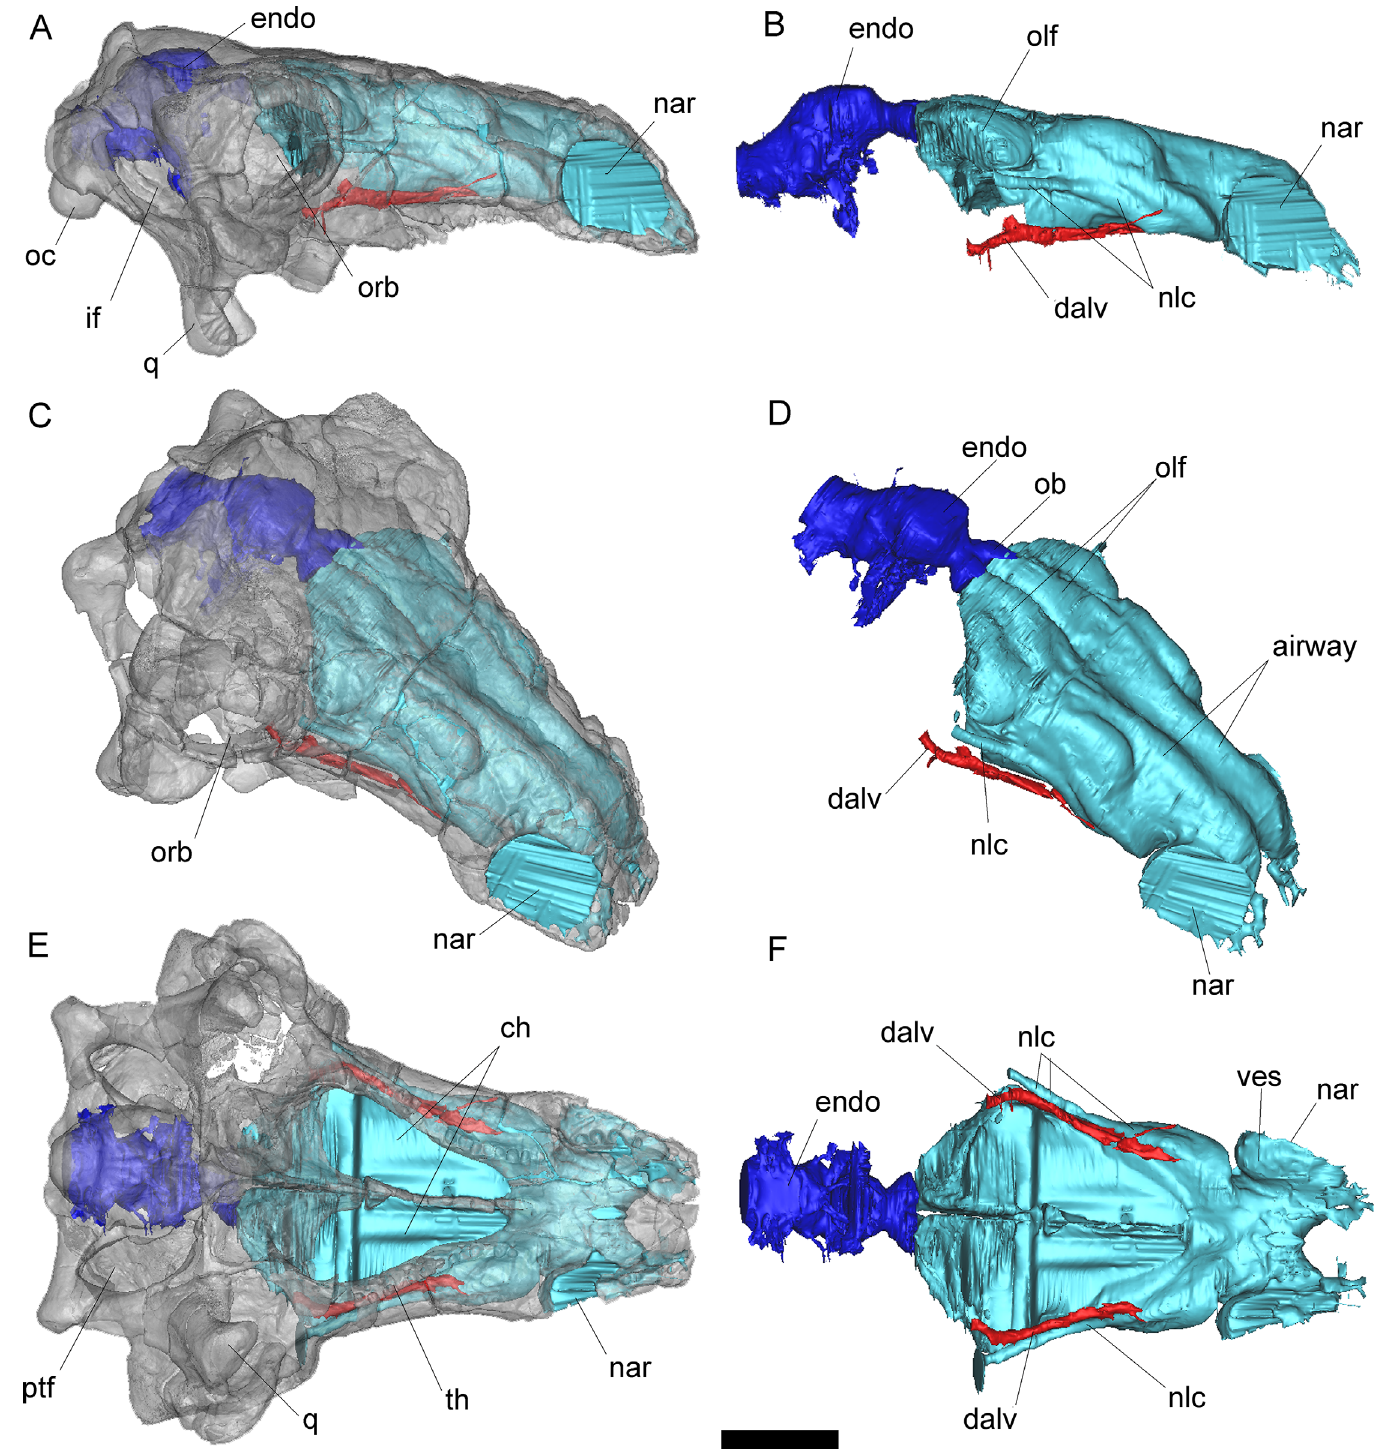
Fig 2. Volume-rendered CT-based reconstruction of the skull of the nodosaur dinosaur Pawpawsaurus campbelli (FWMSH93B.00026). In the images of the left side the bone is rendered semitransparent to show the endocranial cavity (in blue) and the nasal cavities (in light blue). Skull right lateral (A, B), right anterolateral (C,D) and ventral (E,F) views. Abbreviations: ch, choana; endo, cranial endocast; if, lateral temporal fenestra; nar, external nostrils; oc, occipital condyle; olf, olfactory region of the nasal cavity; orb, orbit; q, quadrate; th, teeth row; ves, vestibular region of the nasal cavity; 1, dorsal alveolar canal (for maxillary branch of trigeminal nerve, and maxillary vein and artery); 2, nasolacrimal canal (for nasolacrimal duct). Scale bar equals 5 cm.